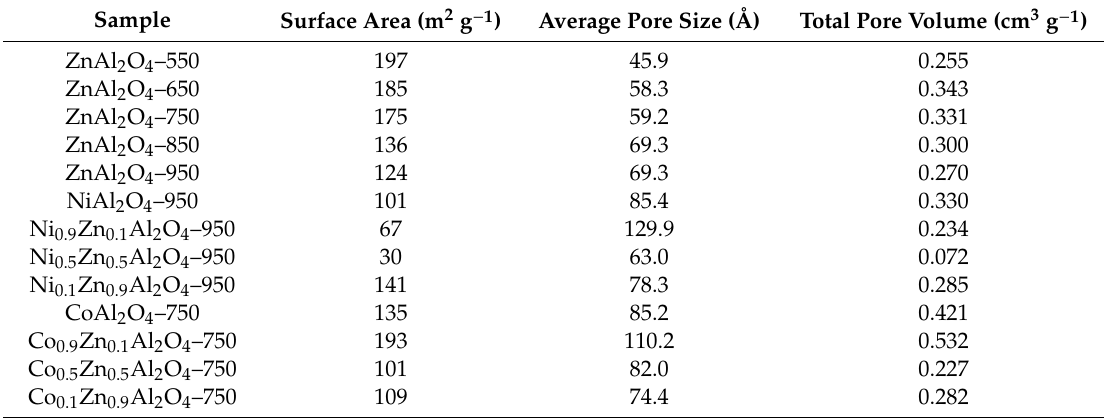
Table 3. Surface area, average pore diameter and total pore volume of samples Zn 1-x M x Al 2 O 4